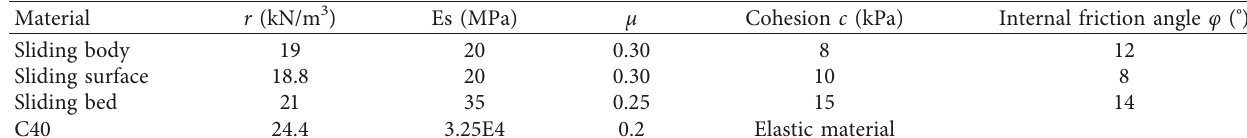
Table 1: Physical and mechanical properties of the test material.